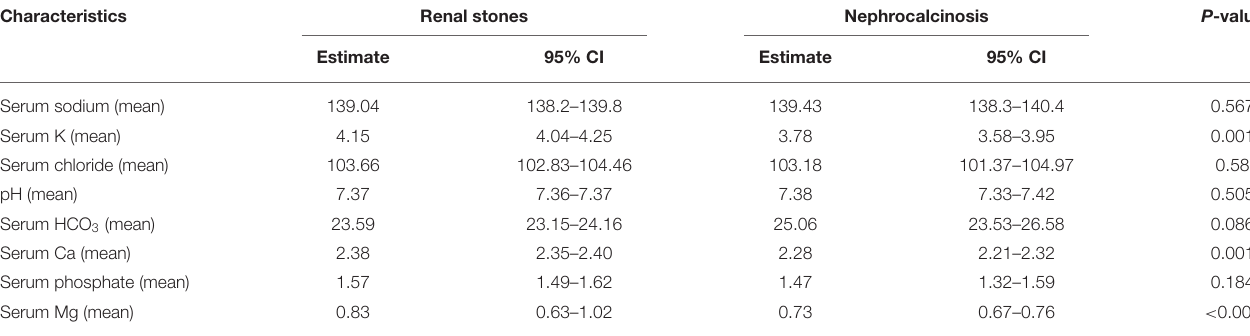
TABLE 4 | Serum electrolyte results among patients with nephrolithiasis/urolithiasis (renal stones) and nephrocalcinosis.